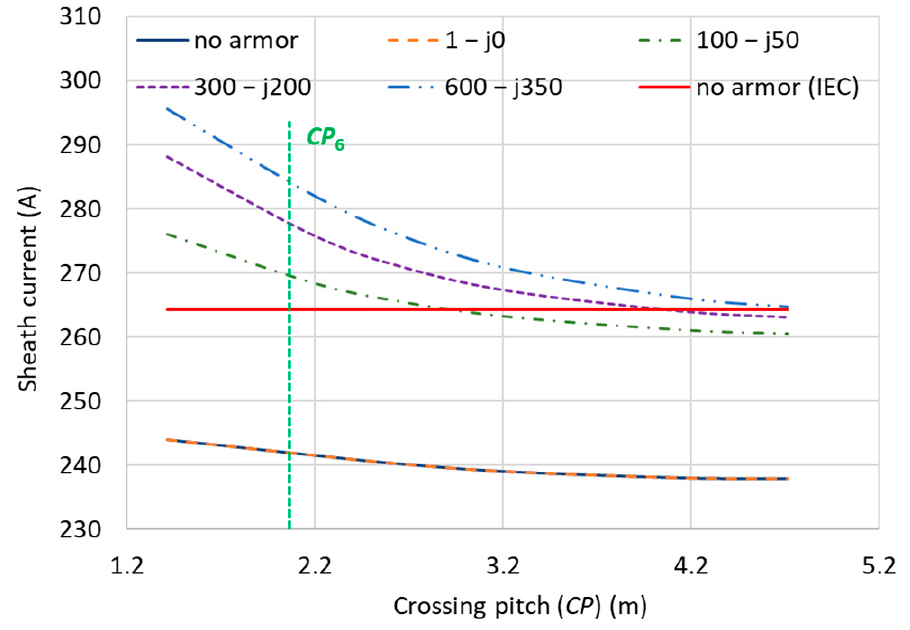
Figure 17. Variation of I s with CP and µ r for Cable 6 (SB) (actual CP 6 of cable included as a refer- ence).